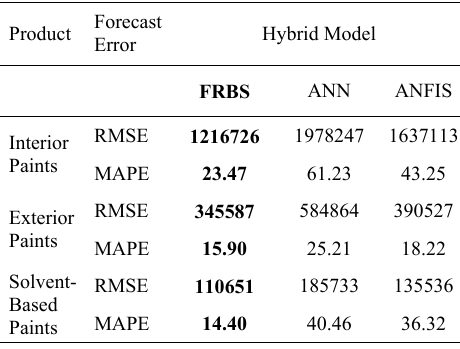
Table 5. Comparison of the different methods used in the hybrid model